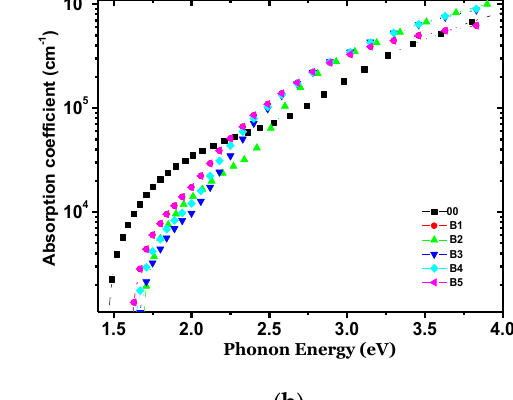
Figure 4. Absorption coefficient vs. phonon energy for two series of thin films: ( a ) n−type films with different H 2 and PH 3 contents; ( b ) p−type films with different H 2 and B 2 H 6 contents.